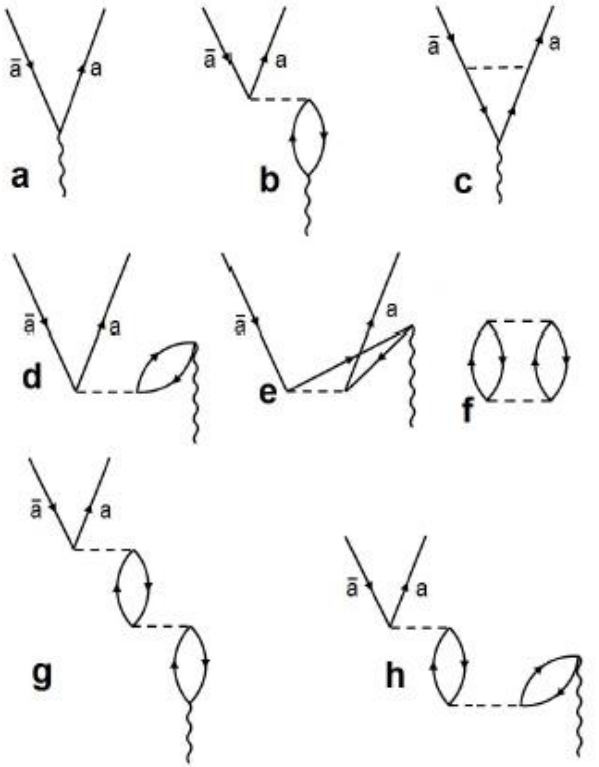
Figure 3. Lowest order Feynman diagrams which contribute to the RRPA transition amplitude for ¯ a . Time axis is from the bottom to the top of the page. The dashed lines represent the transition a → electron–electron correlations, and the wiggly lines correspond to the photon operator. Arrows pointing upward (downward) are the electron (hole): ( a ) represents uncorrelated transition matrix element; ( b , c ) represent, respectively, the first order time-forward (i.e., final state) Coulomb and exchange terms; and ( d , e ) represent, respectively, the first order time-backward (i.e., initial state) Coulomb and exchange terms. ( f – h ) represent higher order ring